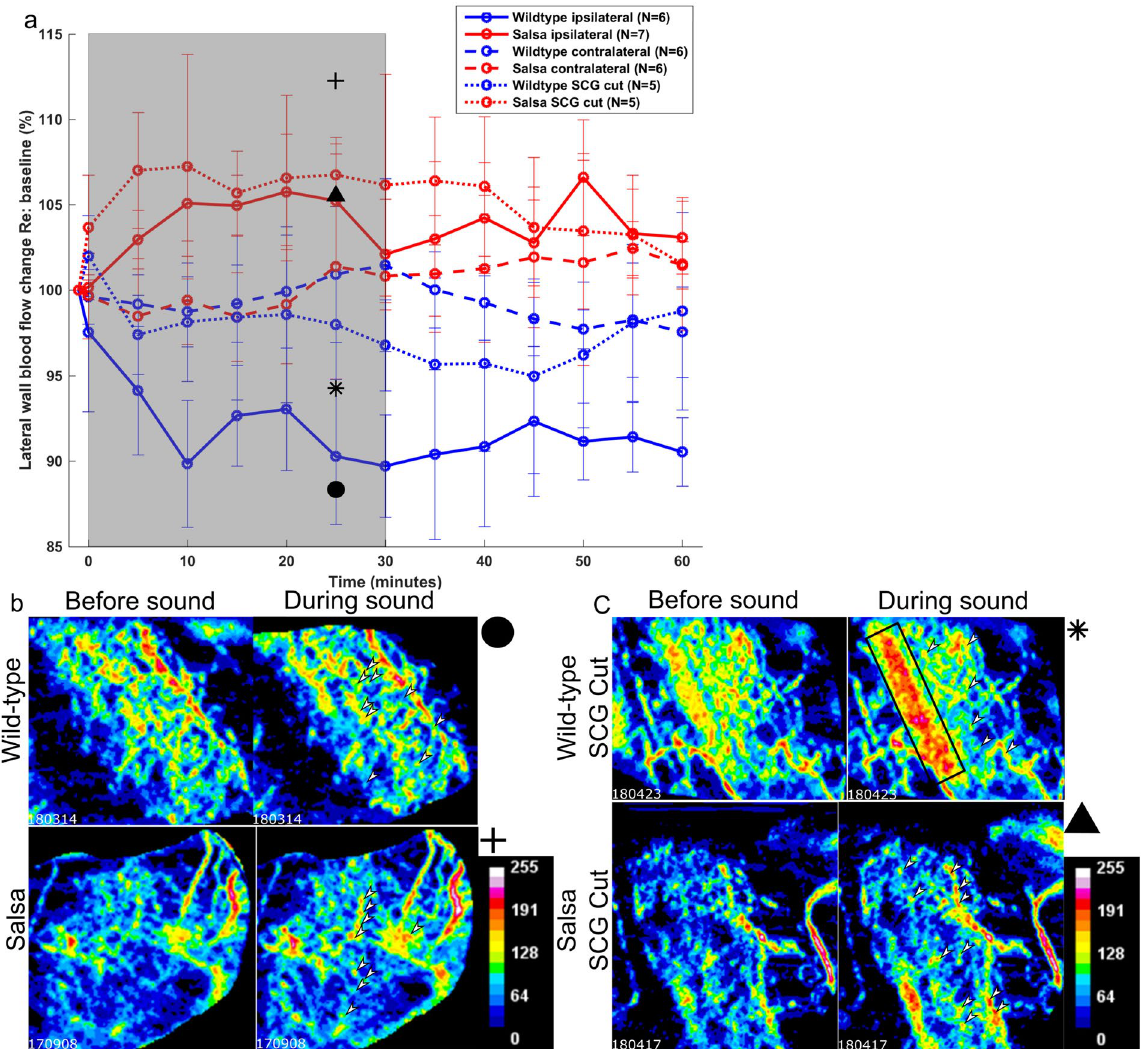
Figure 3. ( a ) Effect of genotype, stimulated ear, and sympathectomy on cochlear blood flow. Relative cochlear blood flow change during and after ipsilateral loud sound exposure in wild-type (N = 6, blue circles, solid line) and salsa (N = 7, red circles, solid line) mice, and during and after contralateral loud sound exposure in wild- type (N = 6, blue circles, dashed line) and salsa (N = 6, red circles, dashed line) mice. MET channel function was a statistically significant factor in cochlear blood flow change between the ipsilateral groups (rmANOVA, F = 7.448, p = < 0.01). Neither MET channel function (rmANOVA, F = 1.076, p = 0.381) nor time (rmANOVA, F = 1.148, p = 0.348) significantly affected contralateral cochlear blood flow. Wild-type mice with the anterior branches of the SCG transected (N = 5, blue circles, dotted line) show significantly reduced cochlear blood flow decline during loud sound exposure compared to intact wild-type mice (rmANOVA, F = 3.043, p = 0.02). There was no statistically significant effect on cutting anterior branches of the SCG of salsa mice (N = 5 red circles, dotted line) compared to intact salsa mice (rmANOVA, F = 0.841, p = 0.510). Loud sound exposure is indicated using the shaded area of the graph. ( b ) Examples, selected at random, of OCTA scans for wild-type (upper panels) and salsa mice (lower panels) before (left) and after 25 minutes (right) of sound exposure. ( c ) as in Fig. 3b but for wild-type (upper panels) and salsa (lower panels) after sectioning of the anterior branches of the SCG. A sound induced flow artifact representing organ of Corti vibration (black rectangle, upper left panel) is shown, and was excluded from the ROI. For Fig. 3b,c, black symbols denote the position of the individual blood flow value on the graph in Fig. 3a. The color bar denotes arbitrary 8 bit pixel intensity in false color. For all during sound images (3 b, c, right hand panels), white arrows indicate example areas of blood flow change relative to before sound (3 b, c, left hand